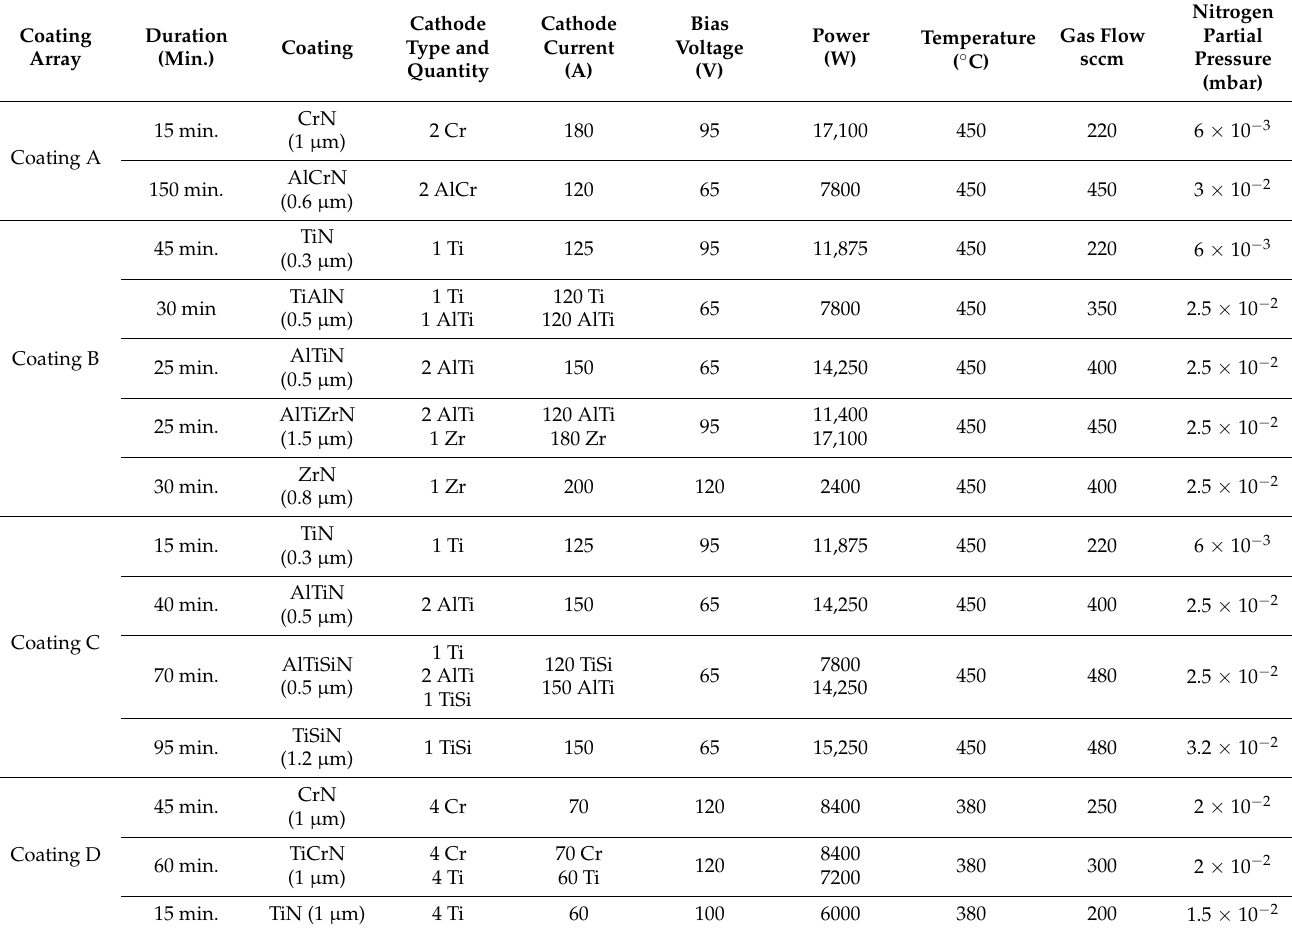
Table 1. Coating parameters of the AlCrN, ZrN, TiSiN, and